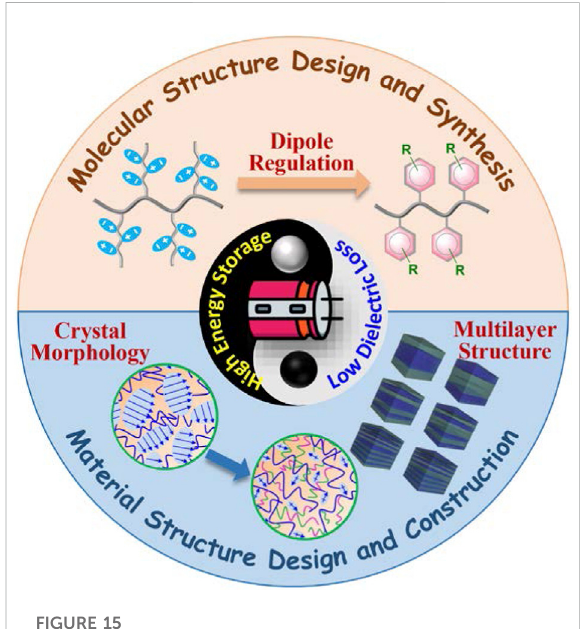
FIGURE 15 Schematics of remaining challenges and future